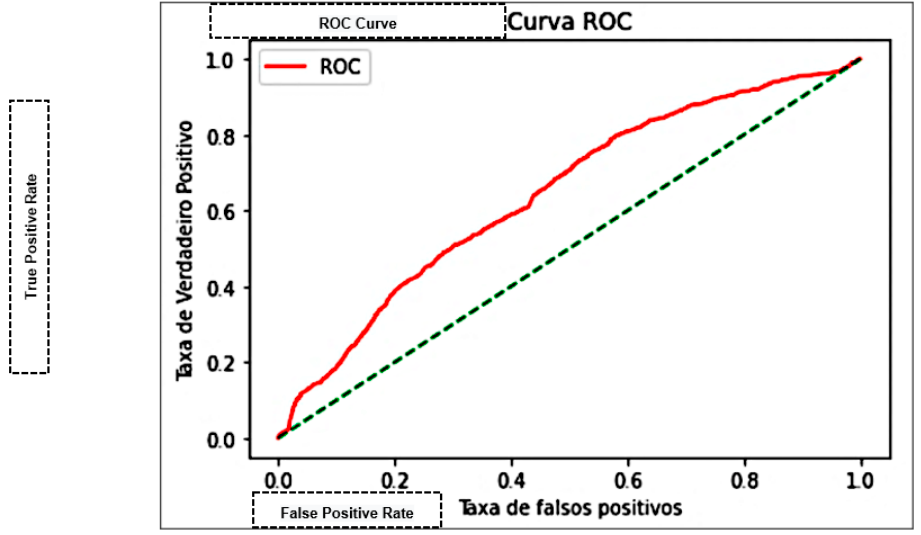
Figure 7. ROC curve—Decision Tree—entropy.